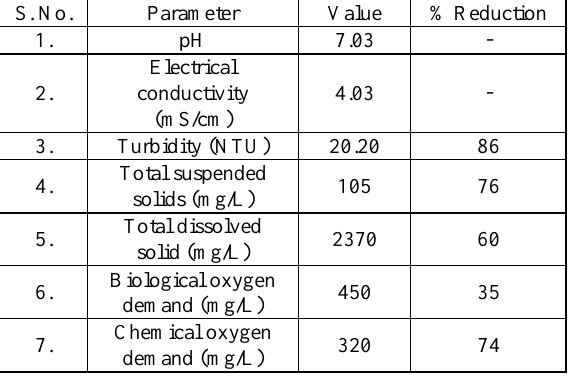
Table 1. Characteristics of waste water after photocatalytic (UV)